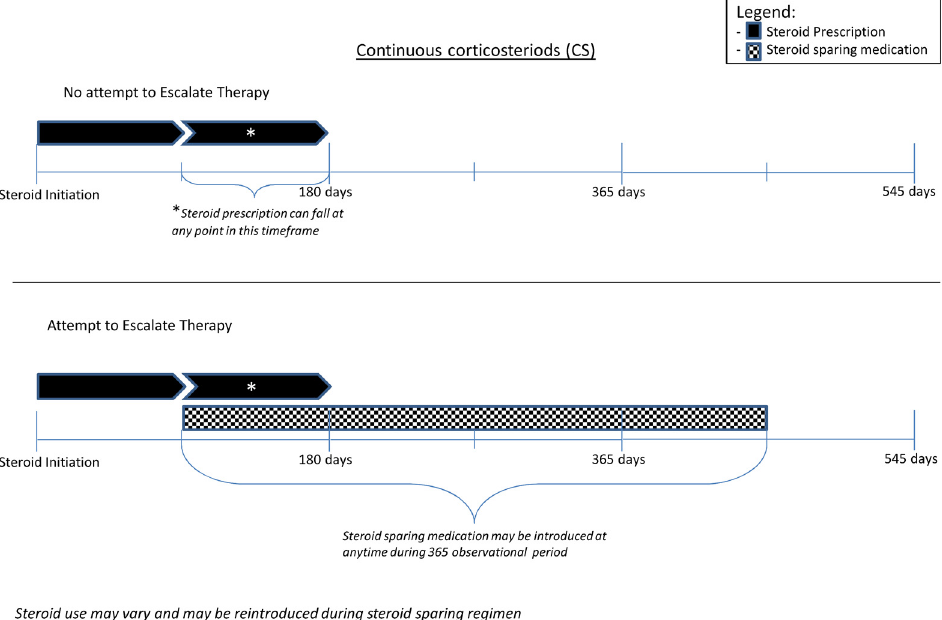
Fig 1. Escalation to corticosteroid-sparing therapy for Veterans who were continuous corticosteroid users (CS).